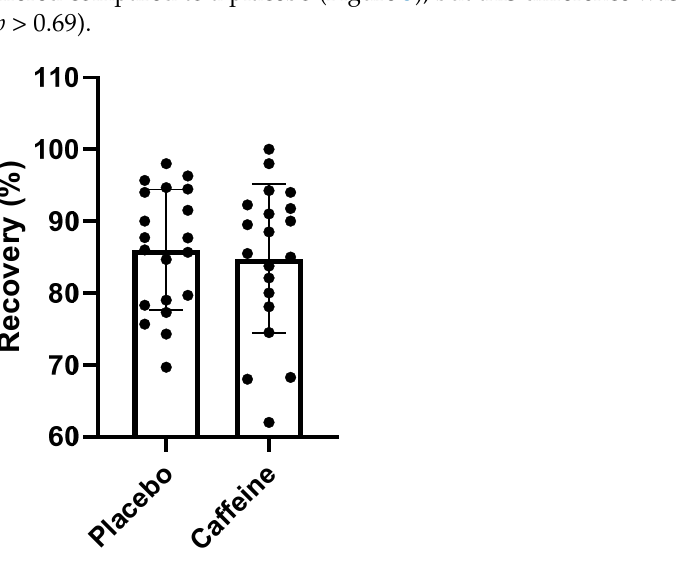
Figure 5. Recovery Test: Caffeine vs. Placebo.